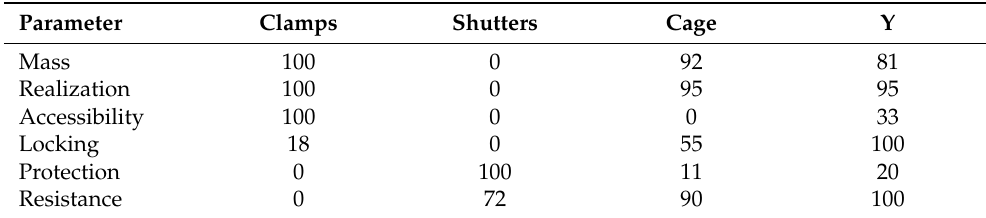
Table 4. Normalized values of the parameters of the six identified solutions for preference ranking. Values are expressed in percentage.